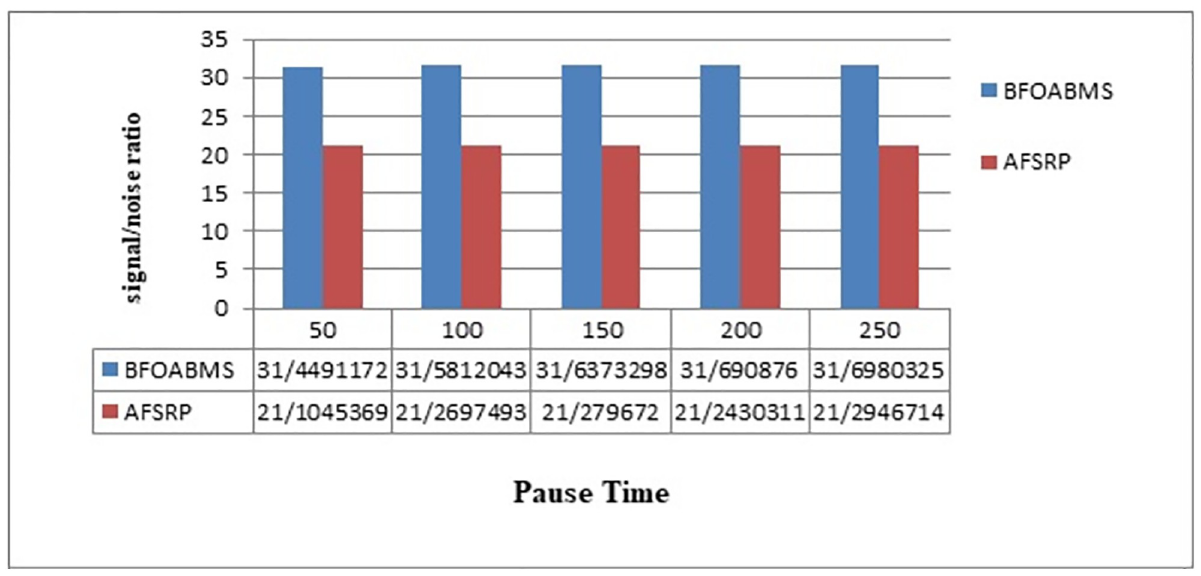
Fig 9. Signal to noise ratio.